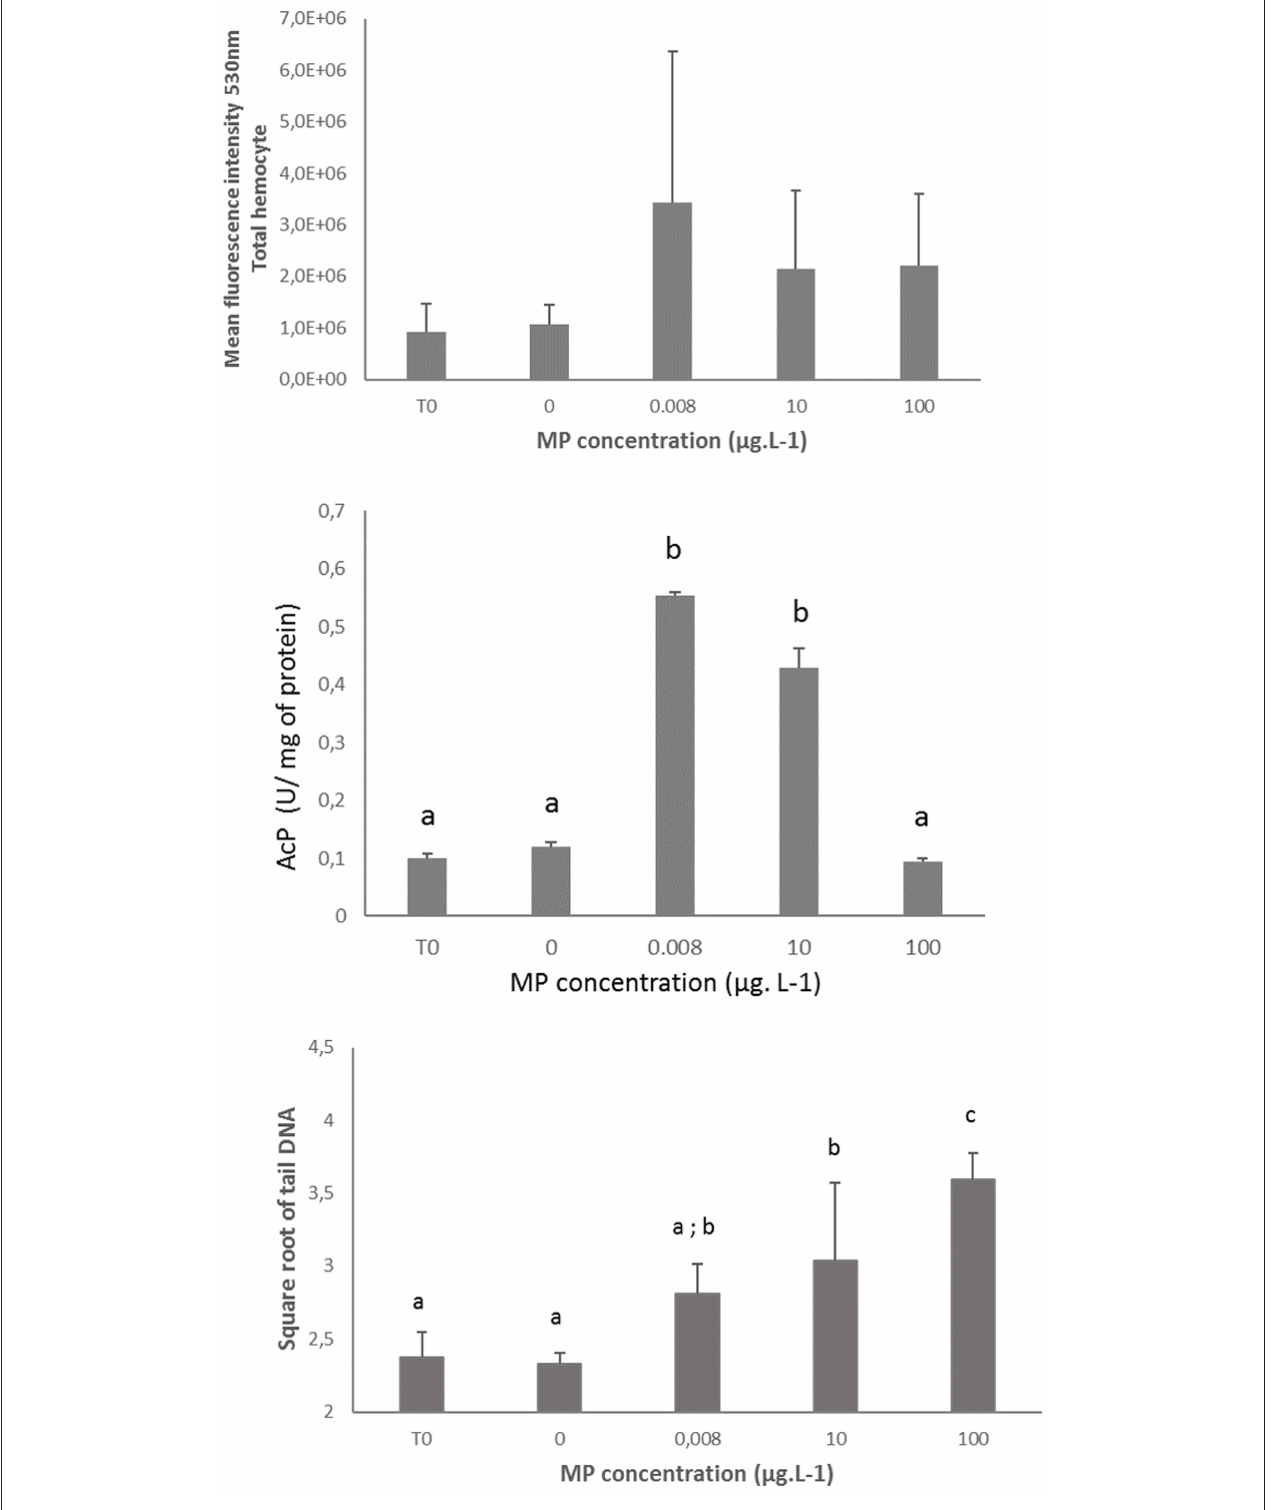
FIGURE 4 | Reactive oxygen species (ROS) production, Acid phosphatase (AcP) activity and DNA integrity in hemolymphe or hemocytes of mussel Mytilus spp at T0 and after 10 days in control mussels (0 MPs L − 1 ) and in mussels exposed to PE and PP microplastics at 0.008, 10 and 100 µ g MPs L − 1 (mean + SD, N = 5 for ROS and DNA and mean + SD, N = 3 for AcP). Different lower-case letters indicate significant differences between control and microplastic exposed treatment ( p < 0.01).